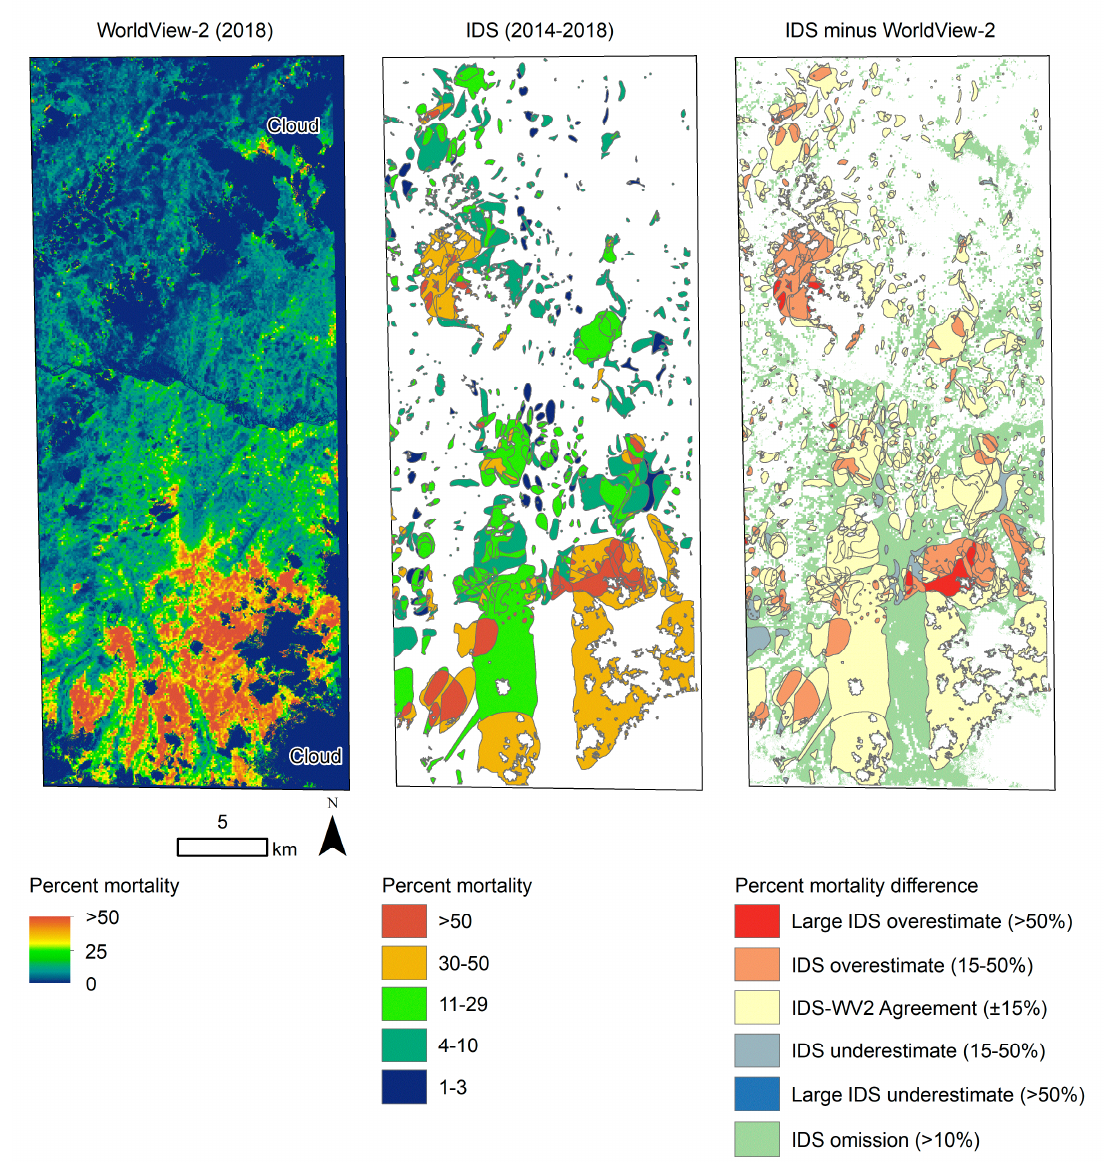
Figure 5. Comparison of percent mortality from WorldView-2 (28 June, 2018 imagery aggregated to 90-m pixel resolution to show percent mortality) and cumulative insect and disease survey (IDS) data. Overall patterns agree. In the difference map, warm colors indicate where the IDS estimated greater percent mortality, cool colors indicate where the IDS estimated less percent mortality, and green indicates where the IDS polygons did not occur but WorldView-2 detected >10% mortality.